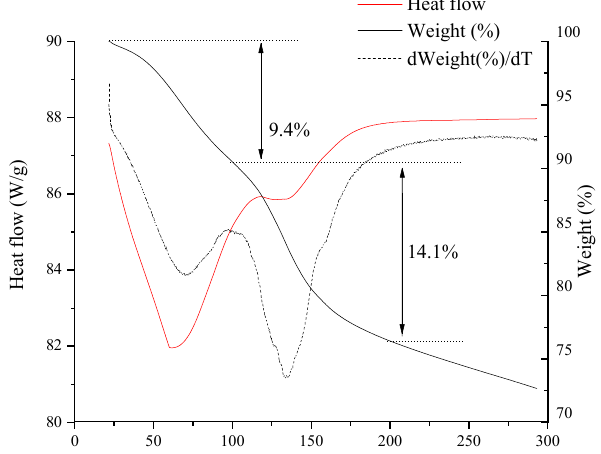
Figure 11. Differential Thermal Analysis and Thermogravimetry (DTA–TG) analysis of Al 7 Zr 3 catalyst recovered after 6th catalytic run of reuse.